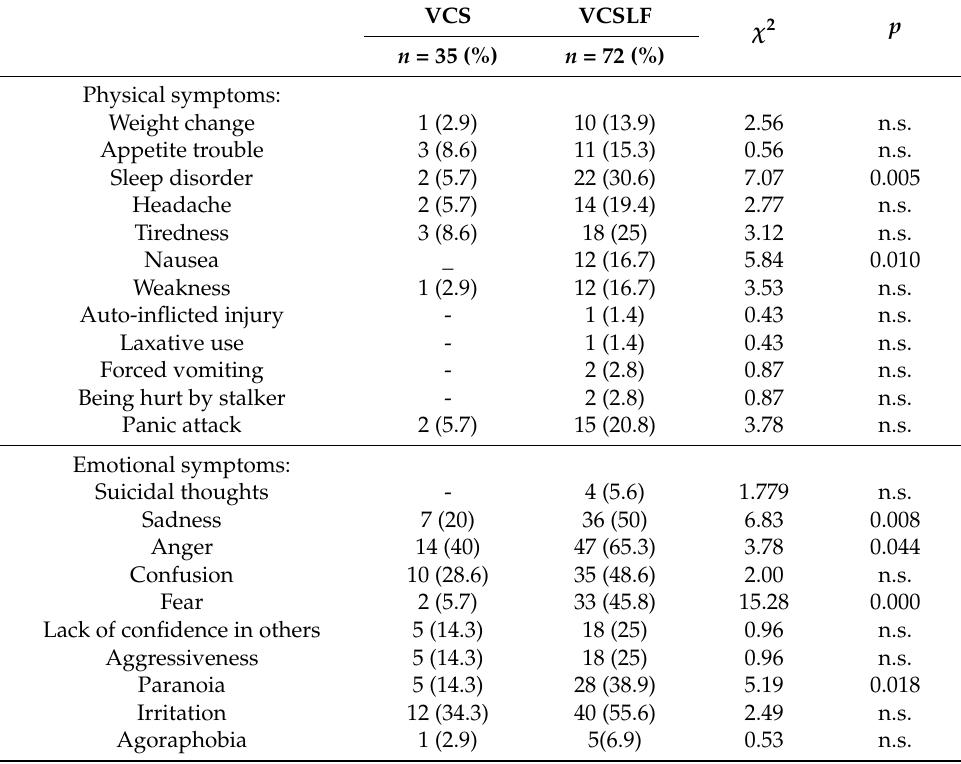
Table 2. Physical and emotional symptoms: comparison between victims of cyberstalking (VCS) and victims who had experienced cyberstalking and previous offline victimization in their lifetimes (VCSLF) ( N =